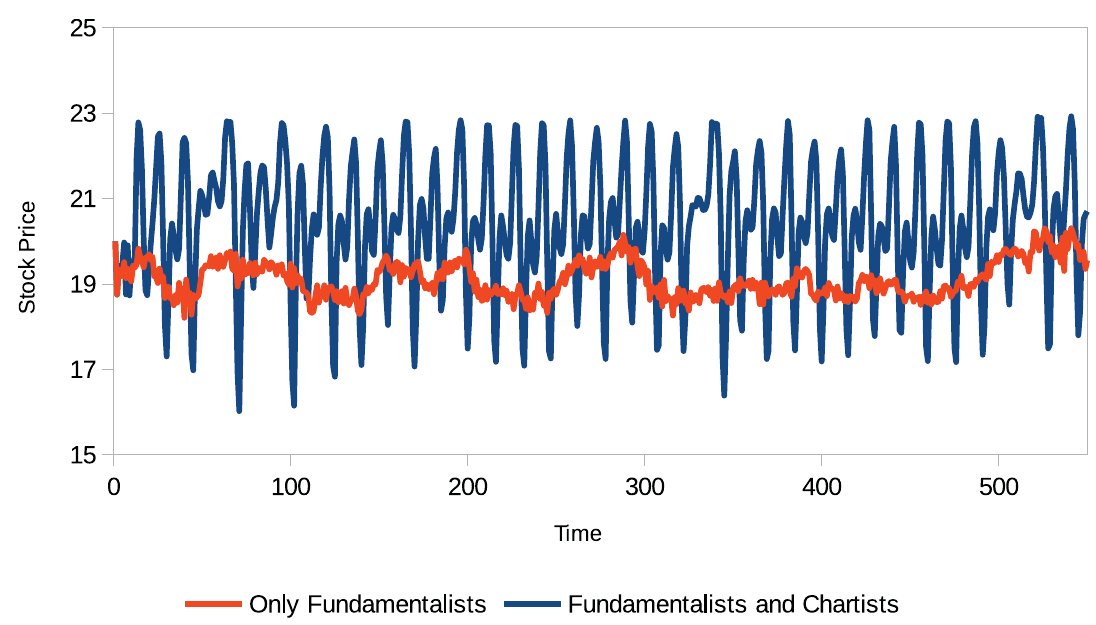
Fig 4. Stock price (different types of agents with confidence). Source: Own creation.